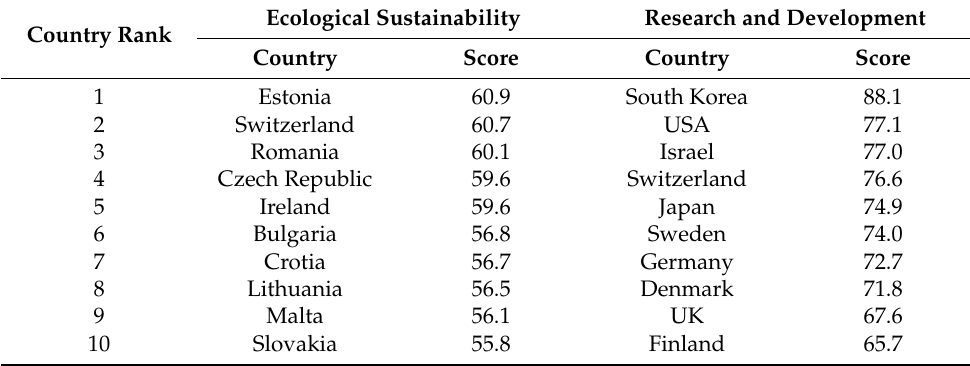
Table 6. Country ranking on key